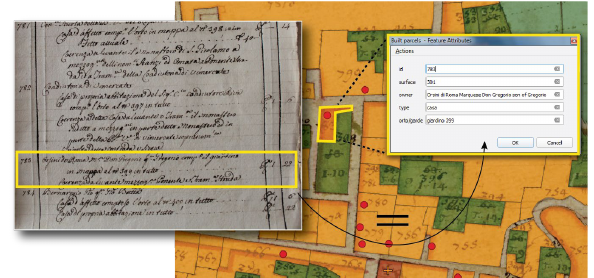
Figure 3. Connection of land register and map. Data are placed in the attribute tables of vector polygon features. Source: